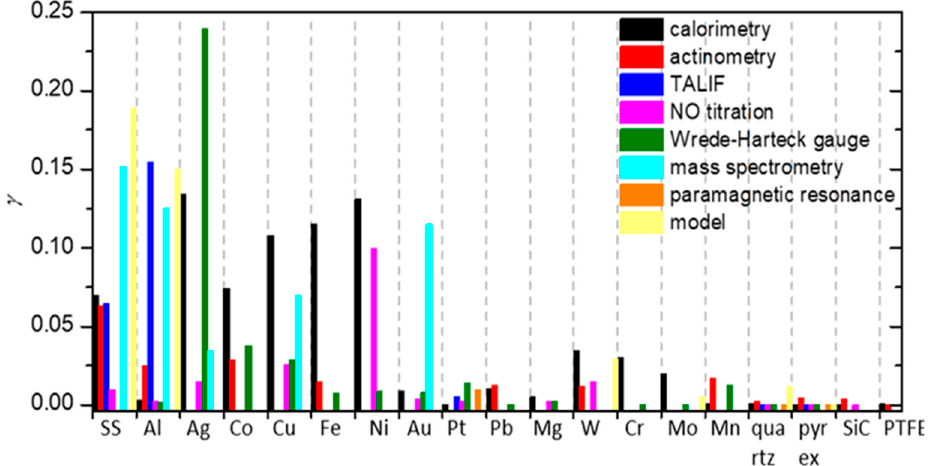
Figure 15. Comparison of average reported recombination coefficients for the most commonly studied materials for different measurement methods.